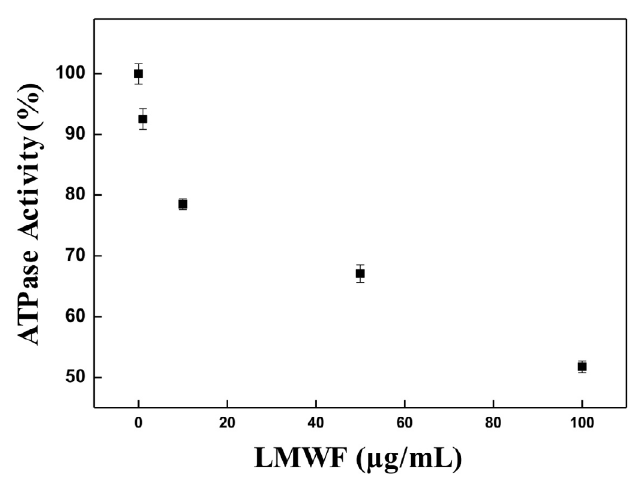
Figure 1. Inhibition Assays of Na+/K+-ATPase Enzyme. Enzymatic inhibition activity induced by LMWF (1; 10; 50 and 100 μg/mL) had demonstrated a dose dependent concentration and the IC mL. Control without enzyme (negative control) and control without LMWF (positive control, 100 % ATPase activity in figure) included in each experiment. The assay was performed in triplicate.